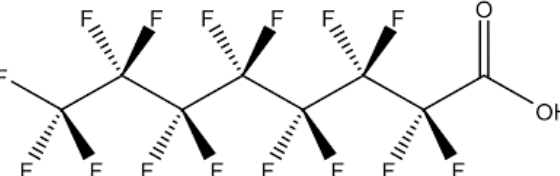
Figure 1. Perfluorooctane alcohol: F 3 C–CF 2 –CF 2 –CF 2 –CF 2 –CF 2 –CF 2 –CF 2 –CF 2 –CH 2 –CH 2 –OH [3].